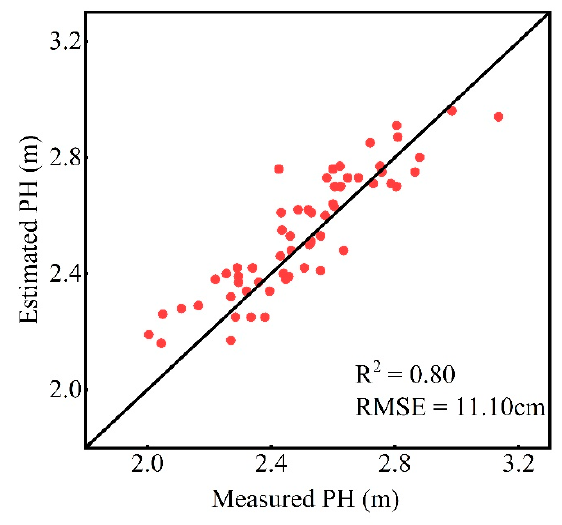
Figure 10. Filling period PH estimates from DLS data in 2019. Table 8. R 2 and RMSE of ER of different densities on DLS platform in 2019 and